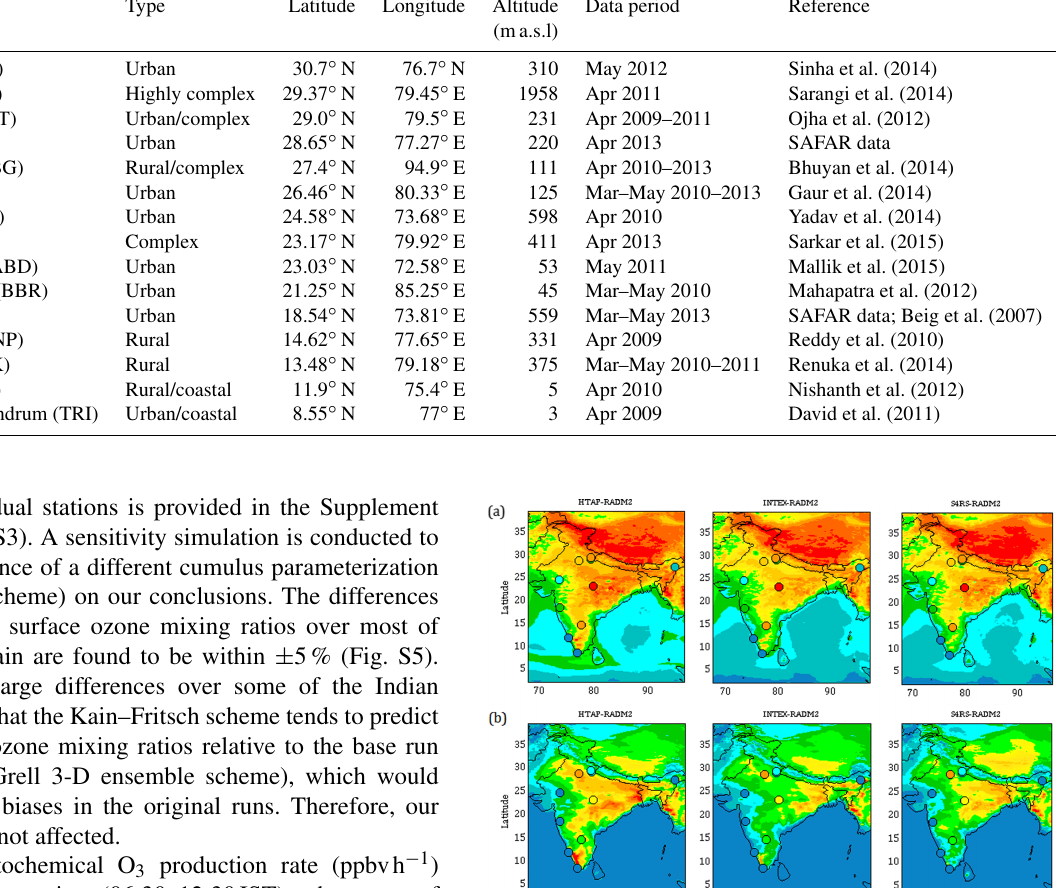
Table 4. List of observation sites and data sources used. Site nomenclature in brackets in column 1 is used in Figs. 1, 5, 6, 9 and 10. Site